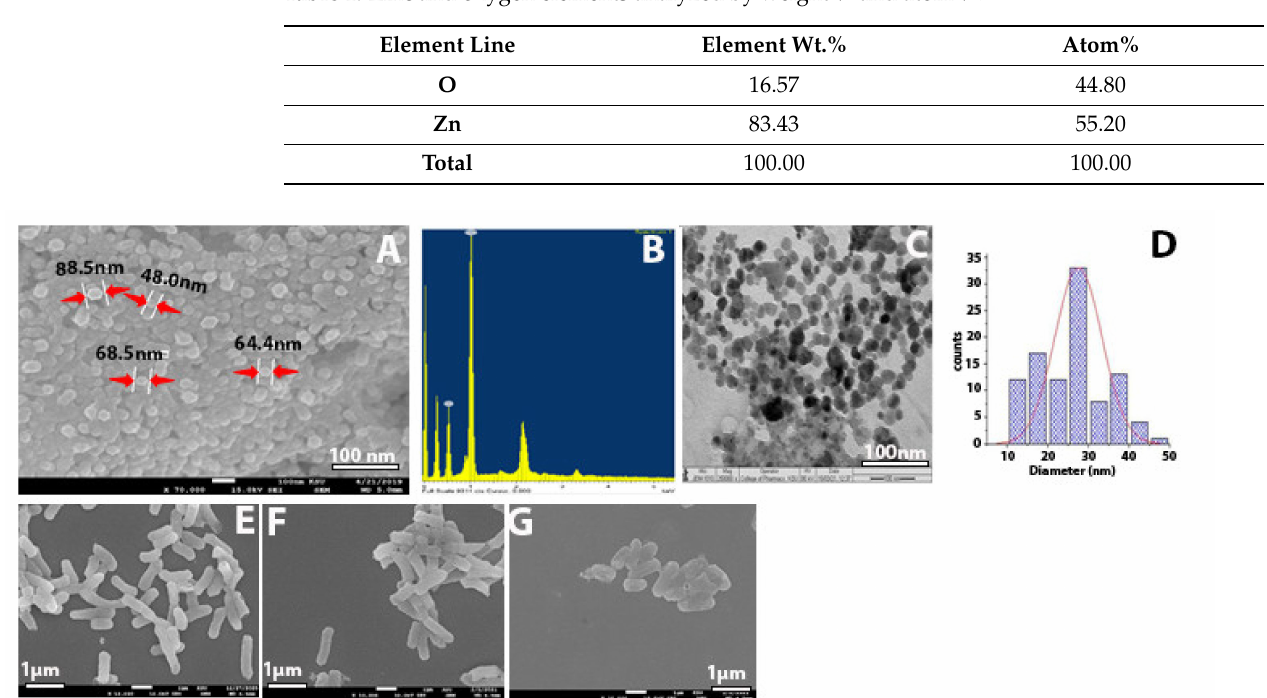
Figure 3. ( A ) SEM of ZnO-NPs. ( B ) EDX results of ZnO-NPs. ( C ) TEM of ZnO-NPs. ( D ) SEM of bacterial control. ( E ) KPC treated with imipenem at 500 mg/mL. ( F ) KPC treated with ZnO-NPs. ( G ) KPC treated with